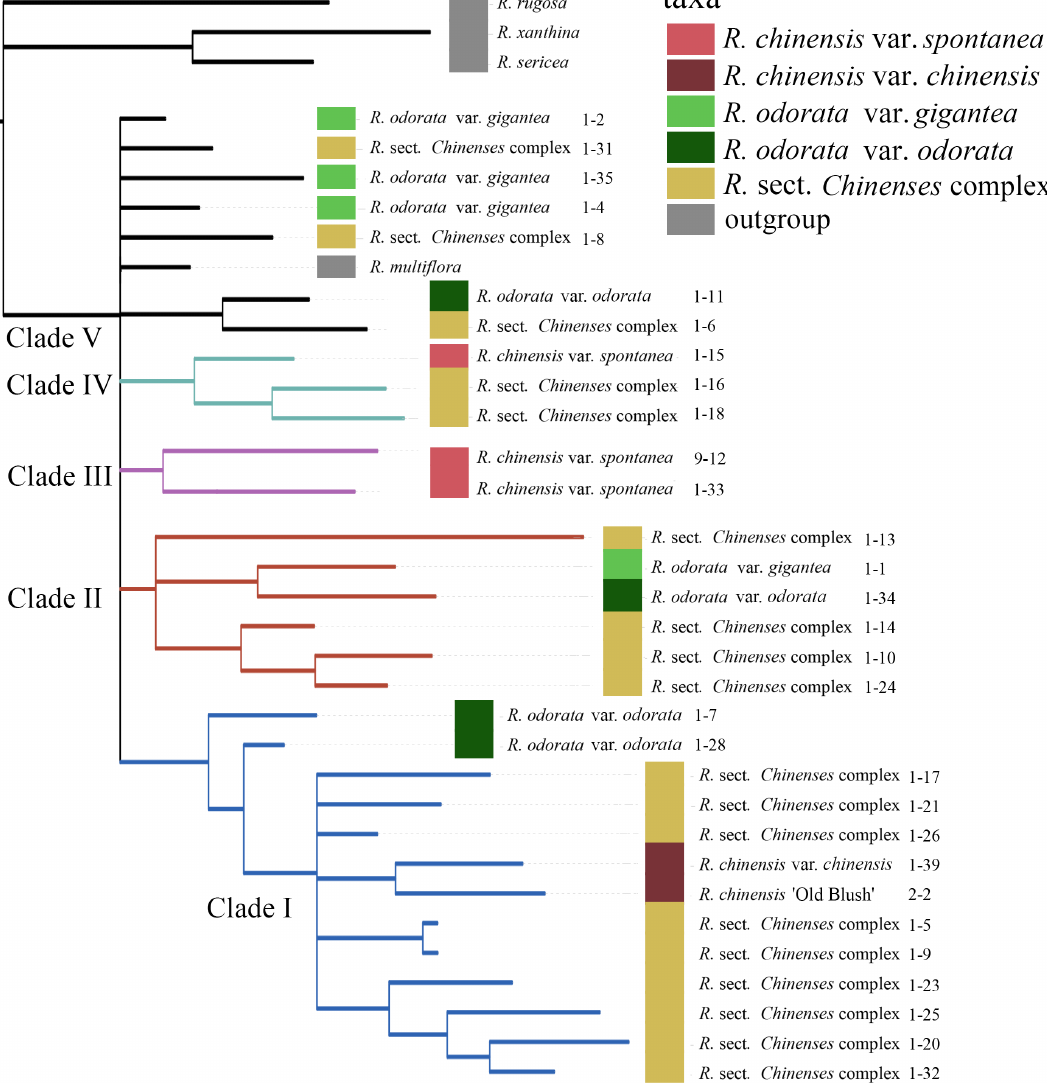
Figure 8. Phylogenetic analysis of R . sect. Chinenses based on single copy nuclear gene